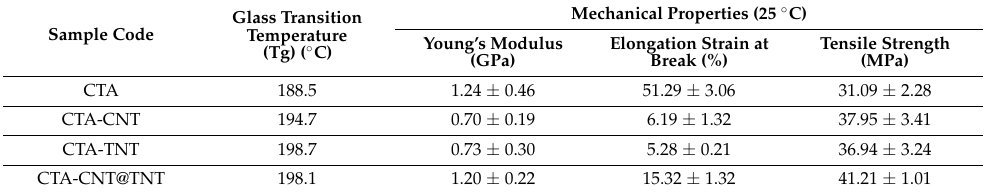
Table 1. Glass transition temperature and mechanical properties of the synthesized